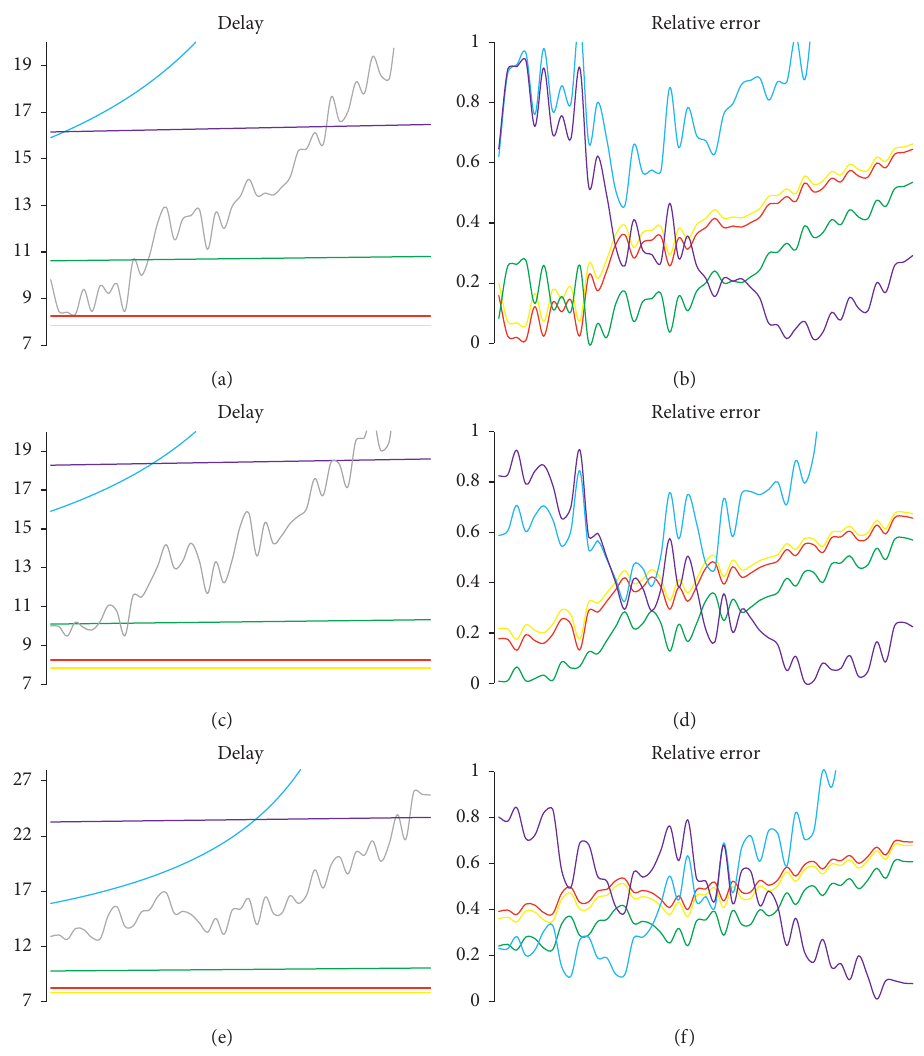
Figure 7: Delay and relative error of different models compared with simulation